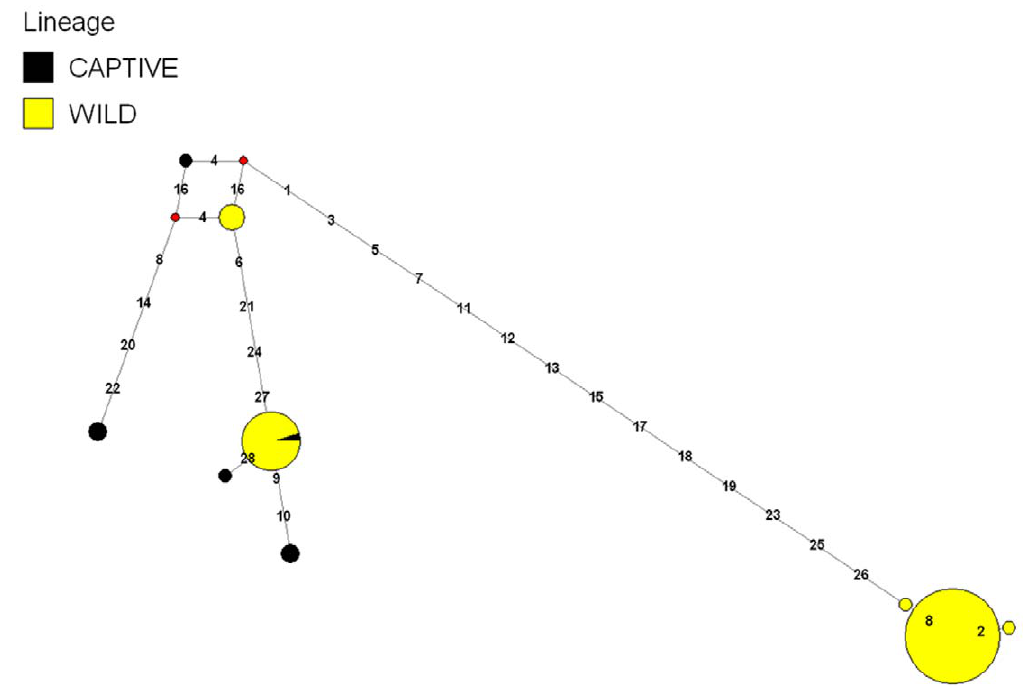
Figure 2. Mitochondrial Haplotype Network. Median joining (MJ) haplotype network for white-tailed deer mitochondrial SNP variation (n=28 validated SNPs) discovered by sequencing reduced representation and random shotgun libraries. Numbers indicate SNP positions in numerical order (Table S8). Node sizes are proportional to haplotype frequency, and all branch lengths are drawn to scale. Median vectors are indicated by small red circles. Nine discrete haplotypes were detected among samples from one free-ranging population (yellow) and representatives from three captive populations (black).